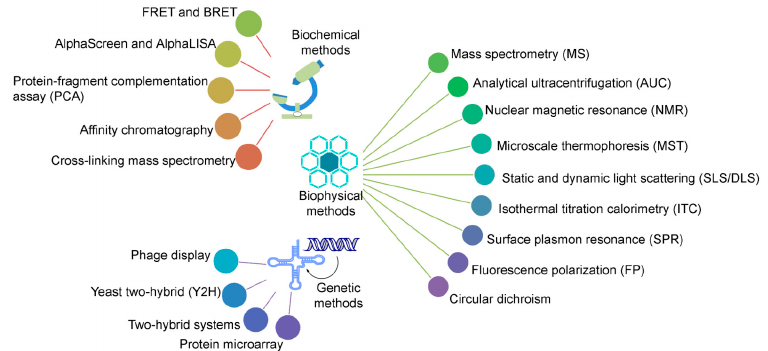
Figure 1. A spectrum of widely characterized experimental methods, based on biochemical, biophysical, or genetic principles. The listed methods define protein–protein interactions at various degrees of affinity as well as specificity [1,2,11– 13,19–40]. The RNA and DNA diagrams, representing the genetic methods, were prepared using the BIOVIA draw (Dassault Systèmes, BIOVIA Corp., San Diego, CA, USA) tool. Fundamentally, the mass spectrometry methods simply measure a mass-to-charge ratio of an ion. Initially, analytes are ionized and then transferred into the gas phase prior to their separation according to mass-to-charge ratios in a mass analyzer. Subsequently, ions that emerge from the mass analyzer are recorded using a detector. The most common way to ionize a peptide or protein sample is electrospray ionization (ESI) [41]. However, a complementary ionization technique, known as matrix-assisted laser desorption/ioniza- tion (MALDI), is often used for its relative ease of use for novices. In a few studies analyz- ing intact protein complexes, MALDI mass spectrometry (MALDI-MS) has been used to- gether with chemical cross-linking techniques [42–44]. Regardless of ionization methods, there are various types of mass analyzers accessible, including the following common ones: ion trap, time-of-flight (TOF), quadrupole, and orbitrap. Each of these mass analyz- ers may be configured in various ways with similar or different mass analyzers to form unique types of mass spectrometers [45]. Quantitative cross-linking mass spectrometry (QCLMS) approaches investigate pro- tein structures as well as the dynamics of their interactions [46–51]. QCLMS is often per- formed using a unique cross-linker that introduces a corresponding mass shift after iso- tope labeling specific only to the cross-linked peptides [46,47,50,52,53], followed by quan- titation of cross-links in MS1. However, the limited availability of isotope labeled cross- linkers restrains the implementation of this approach in QCLMS [54]. Stable Isotope La- beling by Amino Acids in Cell Culture (SILAC), which is a popular option is an alternative to the QCLMS approach, which relies on the metabolic incorporation of isotope labeled amino acids from culture media. Metabolically labeled samples are cross-linked and pooled; relative quantitation is performed from MS1 data using the characteristic mass shift introduced into peptides from the incorporation of isotope labeled amino acid/s [48]. SILAC enables a comparison of multiple samples per analysis (usually two) and it can also enable monitoring amino acid incorporation in a time course (pulsed SILAC), which is especially valuable for exploring dynamics in biological processes. Recently, iCLASPI ( in vivo cross-linking assisted and stable isotope labeling by amino acids in cell culture (SILAC)-based protein identification), an approach combining SILAC and in vivo cross- linking, has been implemented to quantify native protein–protein interactions in